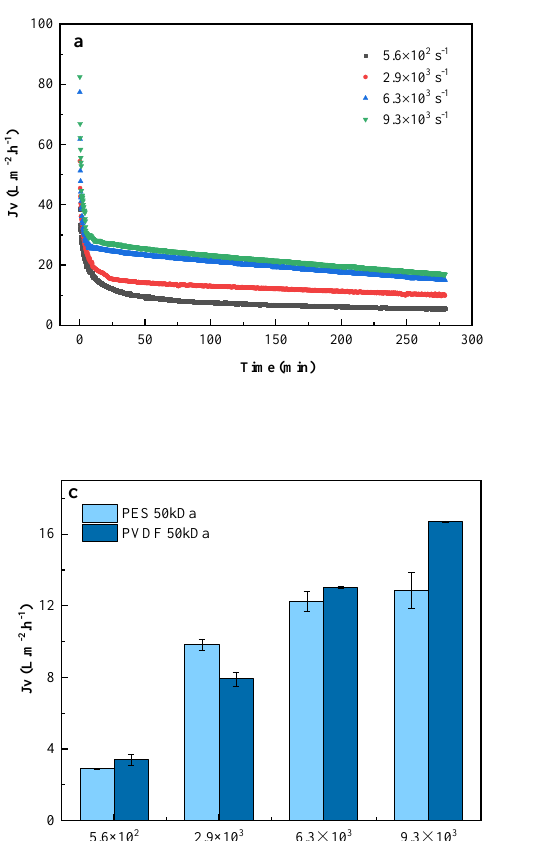
Figure 3. Pollutant removal efficiency of tanning wastewater ultrafiltration at different TMP (shear rate = 2.9 × 10 3 s −1 ).